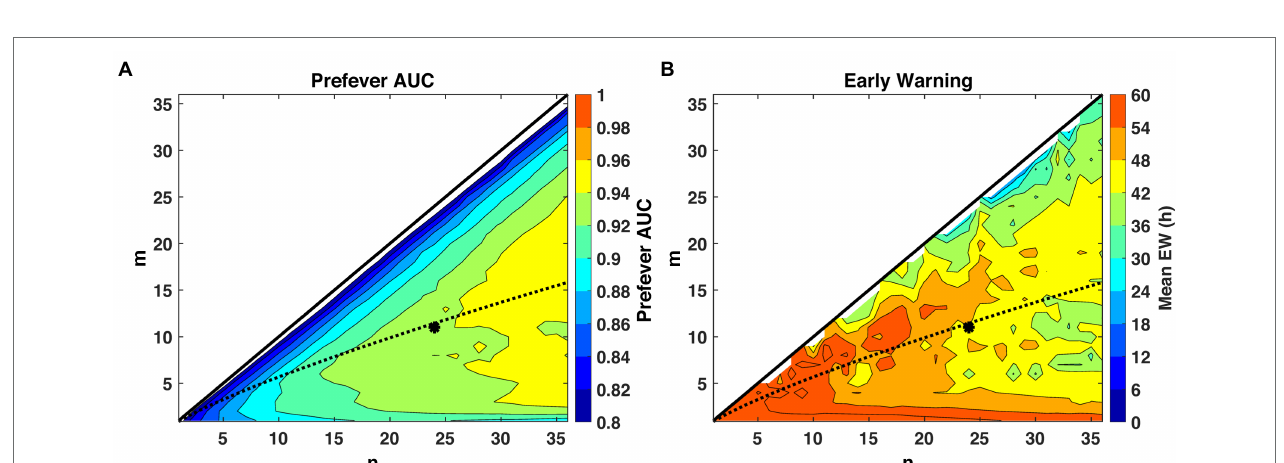
FIGURE 5 | Performance evaluation across detection logic parameters m and n for a system P fa = 0.01. The theoretical optimal value (Shnidman, 1998) of m for a given n and P fa is indicated by the dashed line, and our selected operating point of ( m = 11, n = 24) is indicated by the asterisk. (A) AUC improves with larger values of n , while (B) small values of n promote earlier warning times ( Δ t ) by limiting the buffer length required for a declaration decision.